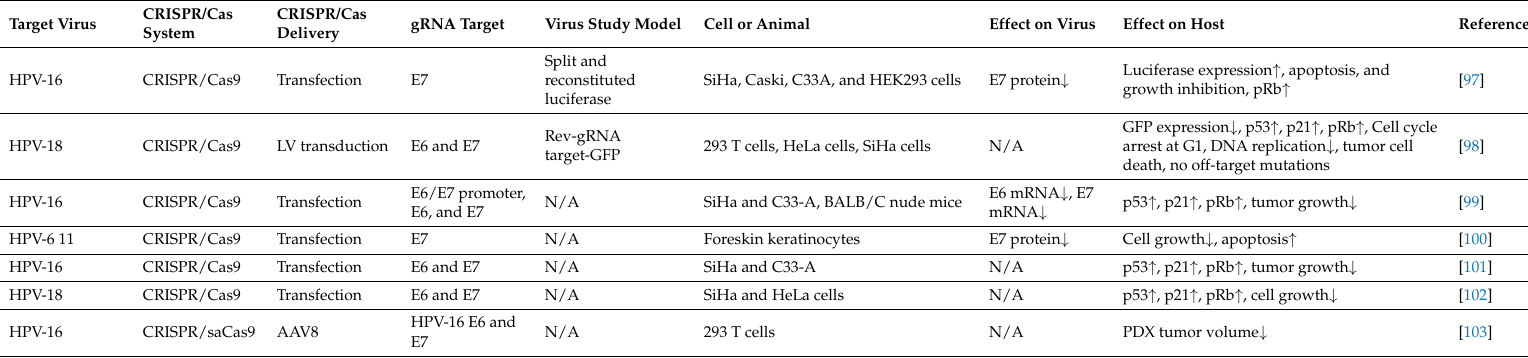
Table 4. Summary of CRISPR/Cas9-based antiviral studies targeting HPV. Abbreviations used within the table are as follows. HPV: human papillomavirus. pRb: retinoblastoma tumor suppressor protein. PDX: patient-derived xenograft.